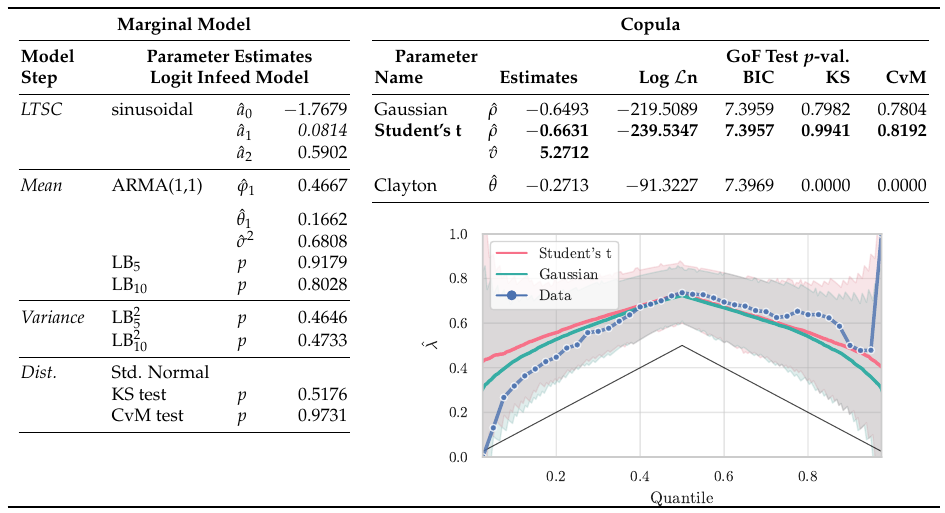
Table 6. Fitted marginal model and copula for the variance reduced portfolio together with the quantile dependence plot of the best performing copula. The resemblance to the overall portfolio is